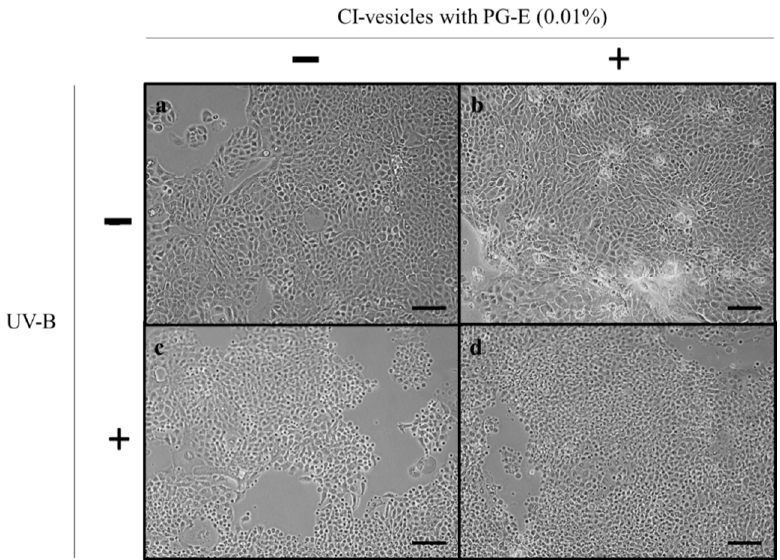
Figure 8. Phase-contrast microscopy images of HaCaT cells without cauliflower inflorescence vesicles (CI-vesicles) and UV-B treatment ( a ), with CI-vesicles and without UV-B treatment ( b ), without CI-vesicles and with UV-B treatment ( c ), and with CI-vesicles and UV-B treatment ( d ). Scale bars = 100 µm. bars = 100 µ